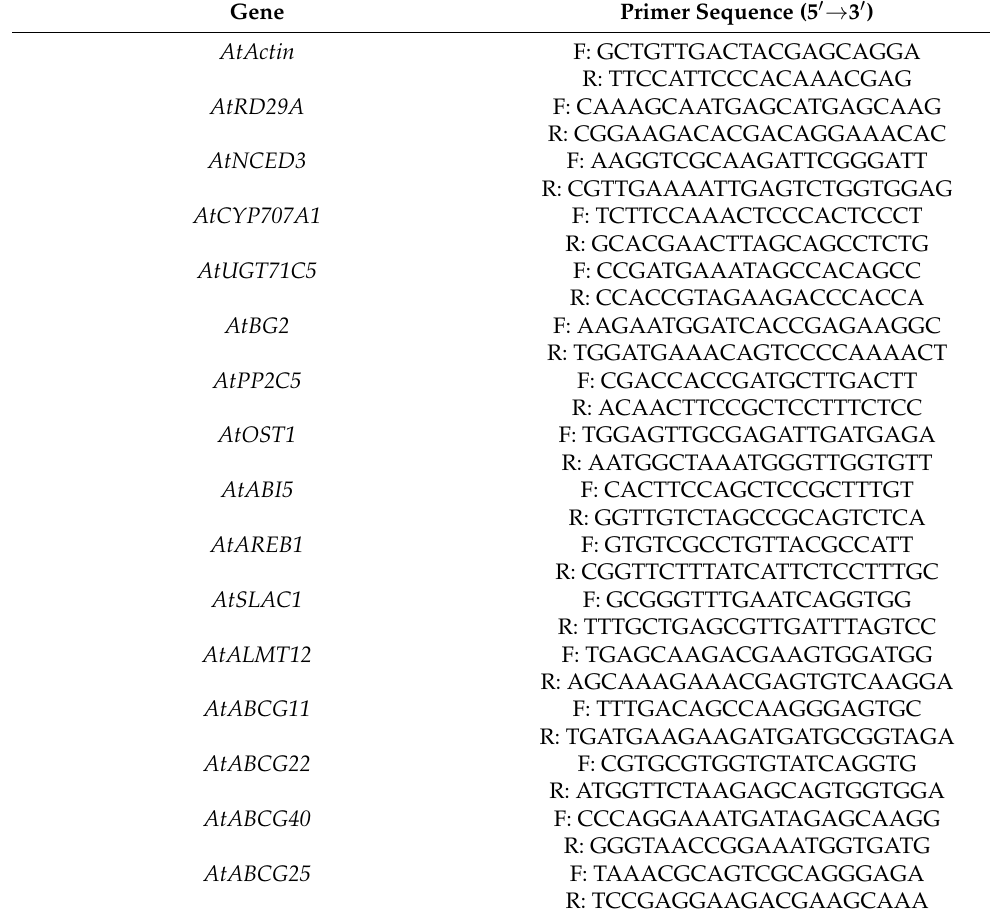
Table 2. The primers used in Arabidopsis